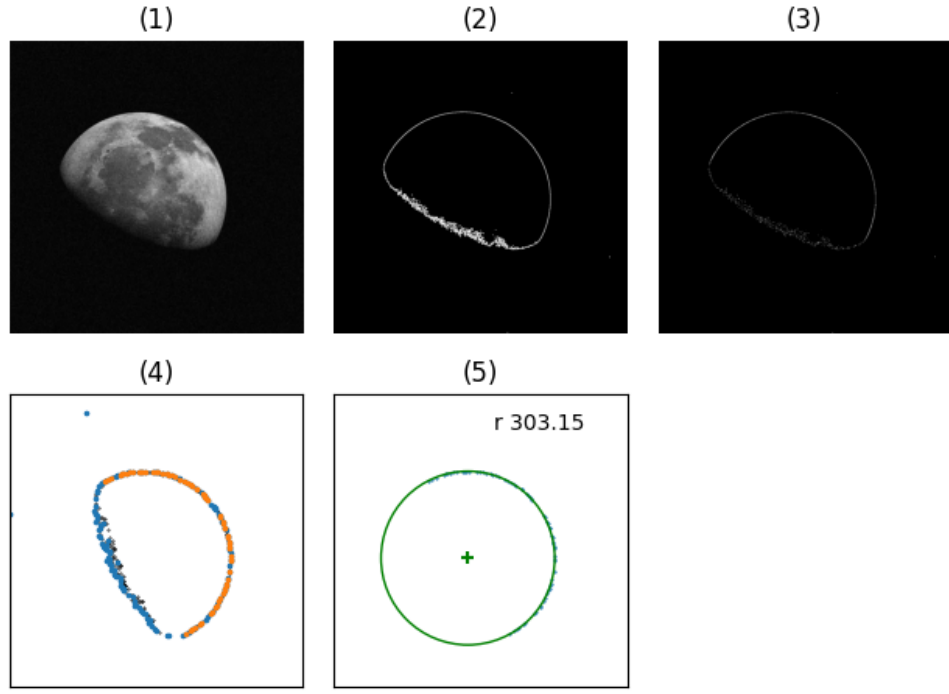
Figure 4. Complete image processing pipeline. ( 1 ) Input image corrupted with additive Gaussian noise; ( 2 ) binary edge mask resulting from Equation (3); ( 3 ) binary edge mask applied to result of edge detection, compared to (2) the resulting image contains the magnitude of the image gradient as floating point values. ( 4 ) Point cloud step. Points without sector binning are in black, dataset with sector binning is in blue and the set of inliers returned by RANSAC is in orange. ( 5 ) Final radius estimation with